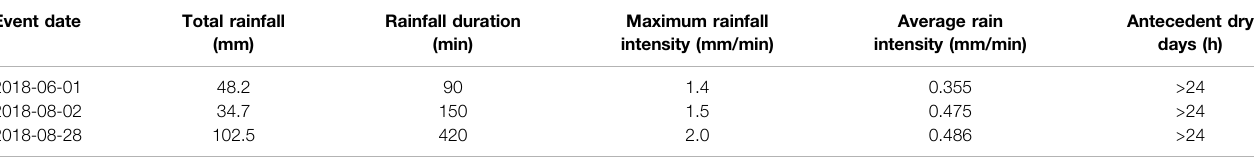
TABLE 1 | Parameters of typical rainfall